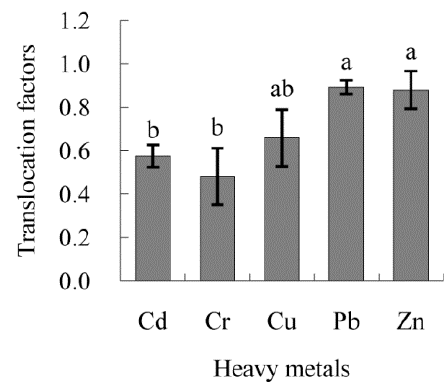
Figure 7. Transfer factors of different heavy metals in B. ischaemum . The different case letters indicate that the means are significantly different among reclaimed scenario ( P < 0.05) with Duncan test (a > ab > b). Table 3. The Pearson correlations among microbial gene abundances and transfer factors of different heavy metals of soil.